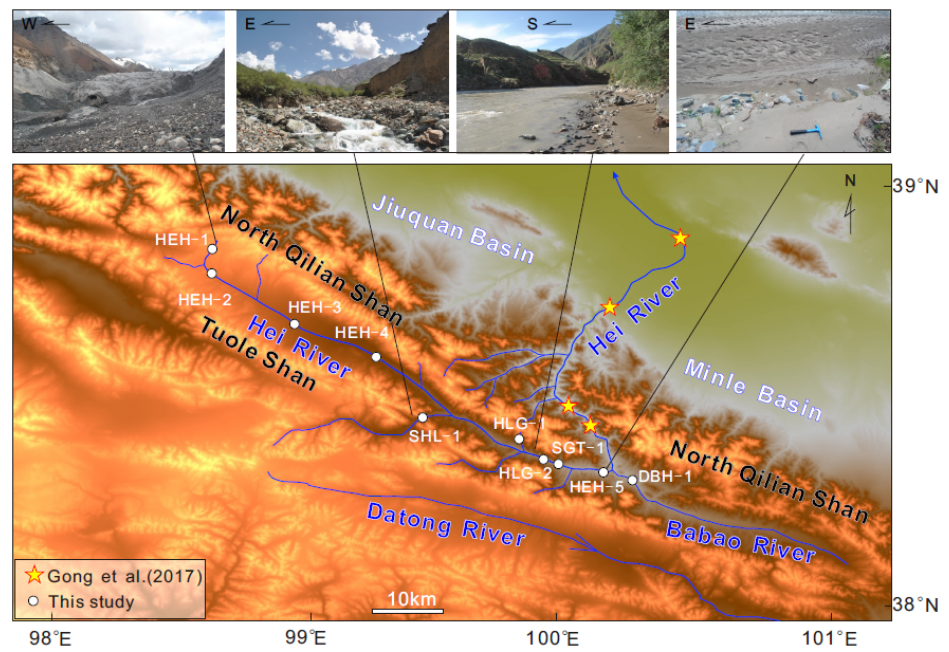
Figure 6. Sampling locations for available detrital zircon U-Pb (stars) and ZFT (circles) data in the Hei River drainage. The color of the stars and circle refer to the different studies.